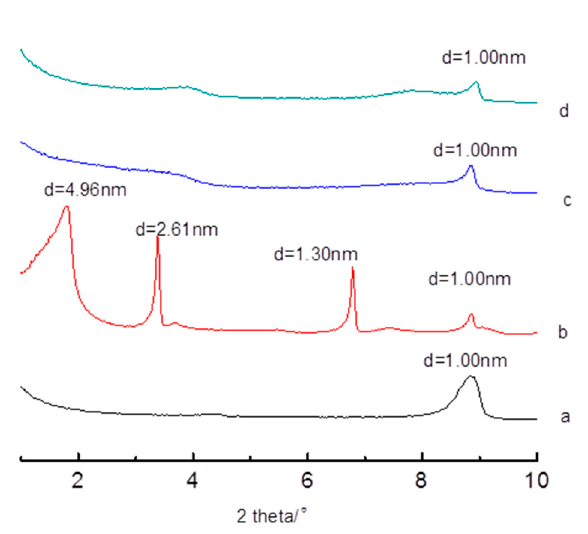
Figure 4. XRD patterns of the intercalated products washed with different solvents at different temperatures. ( a . S3; b . the intercalated product washed with cold DI H 2 O (25 °C); c . the intercalated product washed with hot DI H 2 O (50 °C); d . the intercalated product washed with cold ethanol (25 °C).